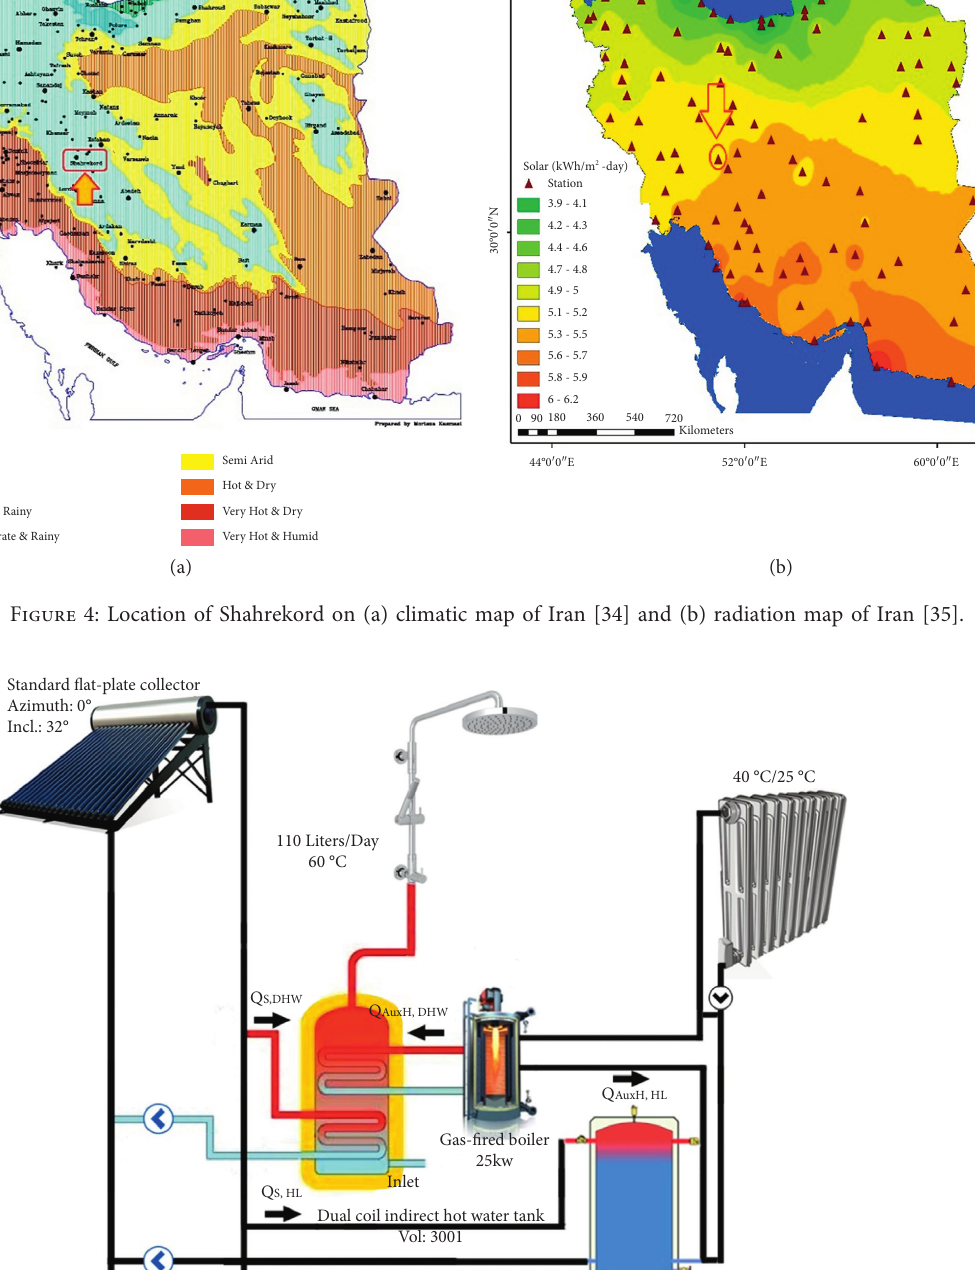
Space heating buffer tank Vol: